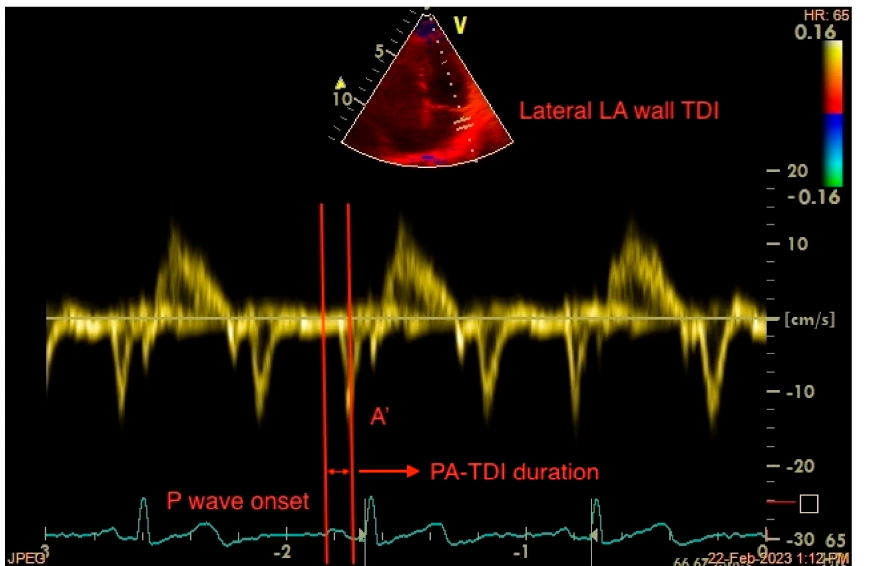
Figure 4. Measurement of the echocardiography-derived total atrial conduction time (PA-TDI duration) between the onset of the atrial electrical activation (P wave on ECG) and the peak of atrial mechanical contraction (A’ wave on TDI). LA: left atrium, TDI: tissue Doppler imaging.